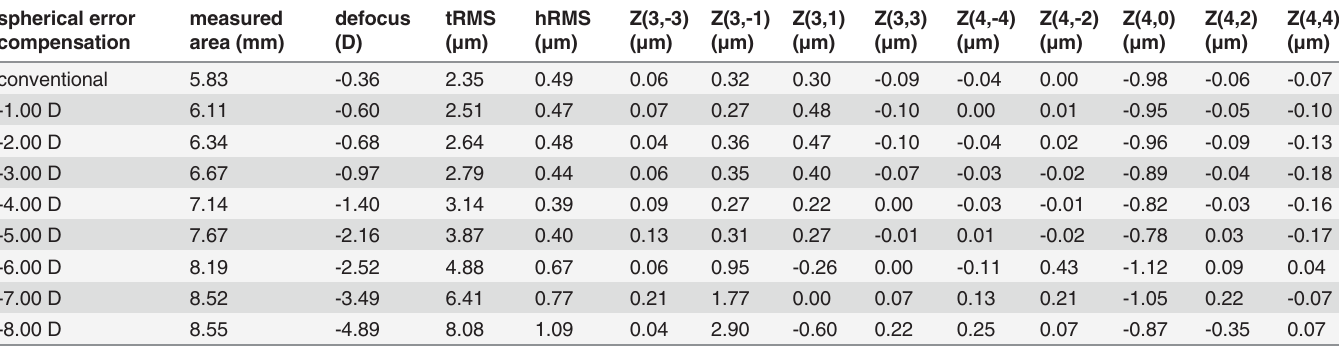
Table 5. The changes of wavefront aberration with the adjustment of spherical error compensation. spherical error